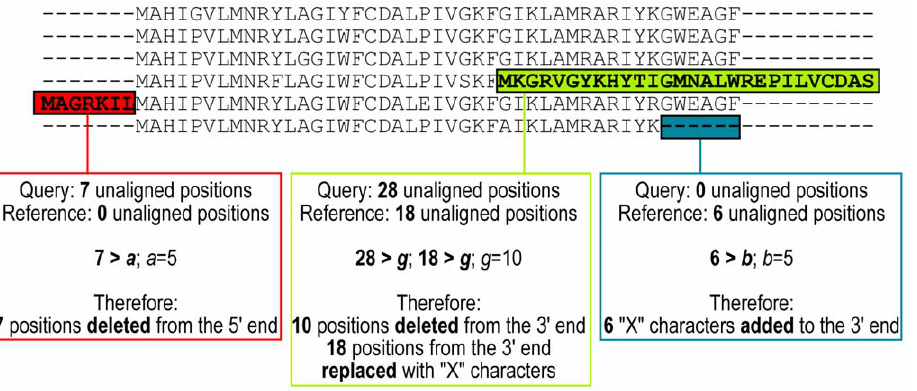
Figure 1. Illustrative examples of the ORFcor approach. A sequence alignment is given where one sequence is overextended (red box), one is chimeric (green box) and one is truncated (blue box). For each altered sequence, the consensus unaligned sequence positions for both the query and reference are indicated, compared with the relevant (non-default) parameters, and the resulting alterations to the sequences indicated.